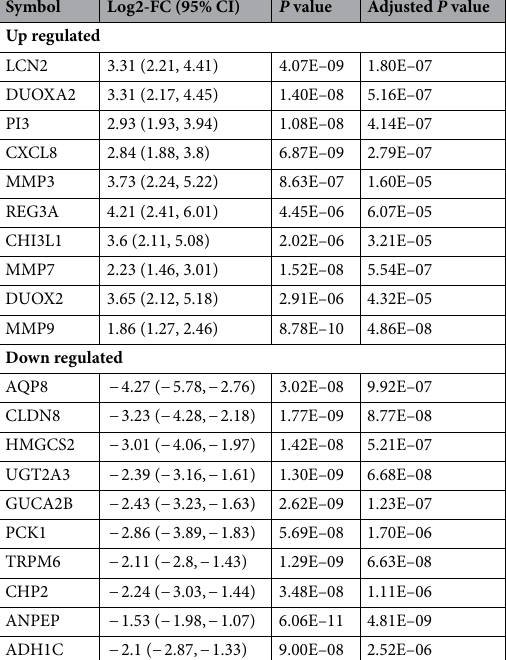
Table 2. Top 10 up- and down-regulated genes in meta-analysis. Genes were ranked using the TopConfects approach. The adjusted P value was determined using the Benjamini Hochberg